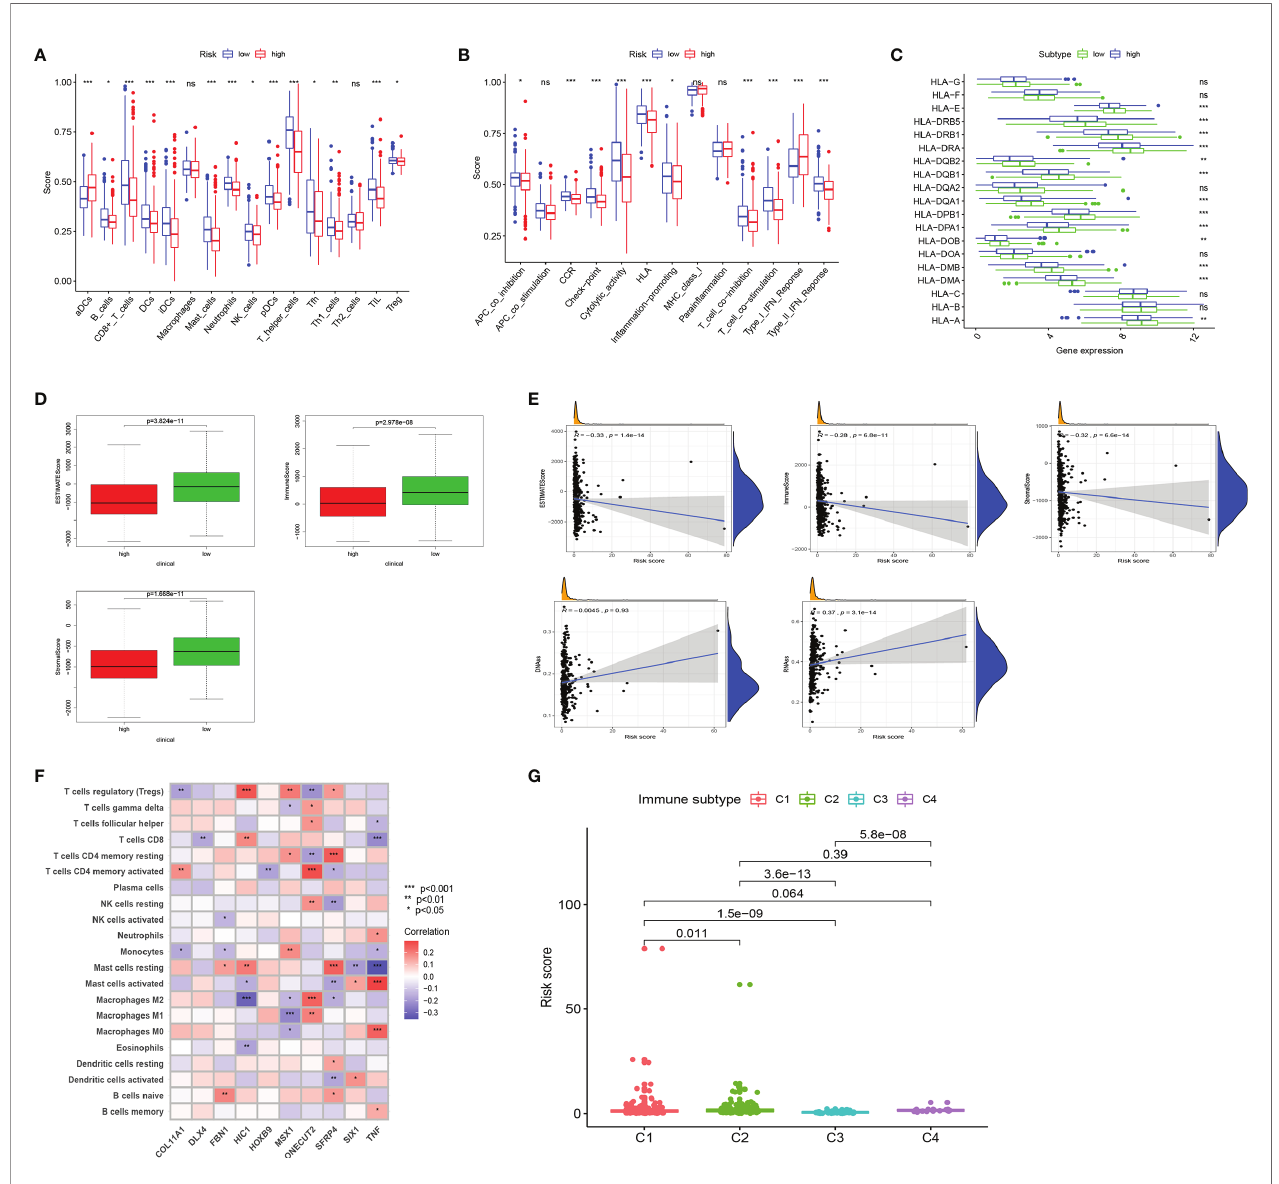
FIGURE 4 | Landscape of immune cell in fi ltration. (A) Comparison of 16 tumor immune-related cells in the high-risk and low-risk groups. (B) Comparison of 13 immune-related functions in the high-risk and low-risk groups. (C) The distribution of HLA-related genes of the high-risk and low-risk groups. (D) Comparison of ESTIMATES score, Immune score, and Stromal score in high-risk and low-risk groups. (E) The relationship between risk score and ESTIMATES score, Immune score, Stromal score, RNAss, and DNAss. (F) The correlation between 10 ERGs and immune cells in fi ltration. (G) Comparison of the risk score in different immune in fi ltration subtypes. EC, endometrial cancer; ROC, receiver operating characteristic; EMT, epithelial – mesenchymal transition; ERG, EMT-related gene; AUC, area under the curve; HLA, human leukocyte antigen. Adjusted p-values were shown as ns, not signi fi cant; *p < 0.05; **p < 0.01; ***p <